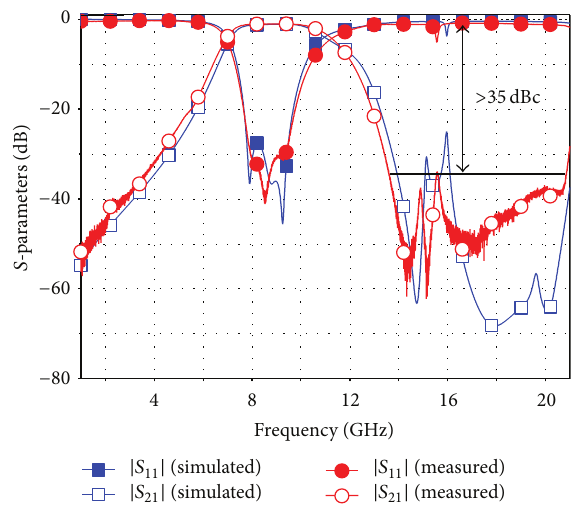
Figure 9: Comparison between measured and simulated scattering parameters of proposed HMSW-DGS